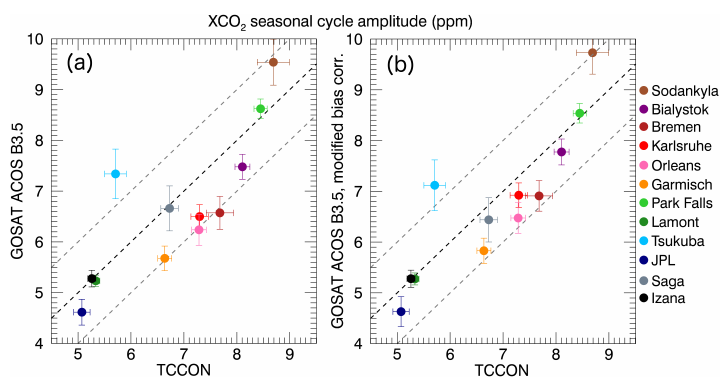
Figure 5. Seasonal cycle amplitude for ACOS (vertical axis) and TCCON (horizontal axis) for all the 12 NH sites used in the validation. The dashed black line corresponds to the one-to-one line, and the grey lines denote ± 1.0ppm. Panel (a) shows the standard bias-corrected ACOS B3.5, and panel (b) shows ACOS B3.5 with a modified bias correction (see Sect. 5.1 for details).